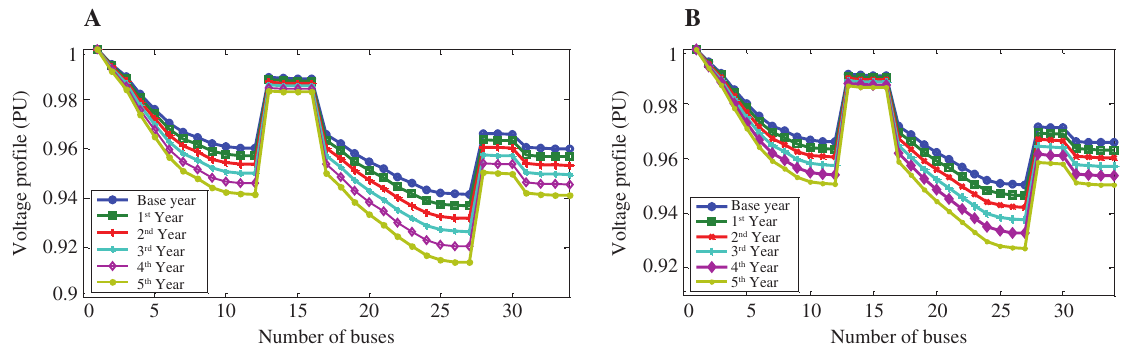
Figure 3: Voltage Profile of the 34-Bus Distribution System. (A) Before compensation considering load growth. (B) After compensation considering load